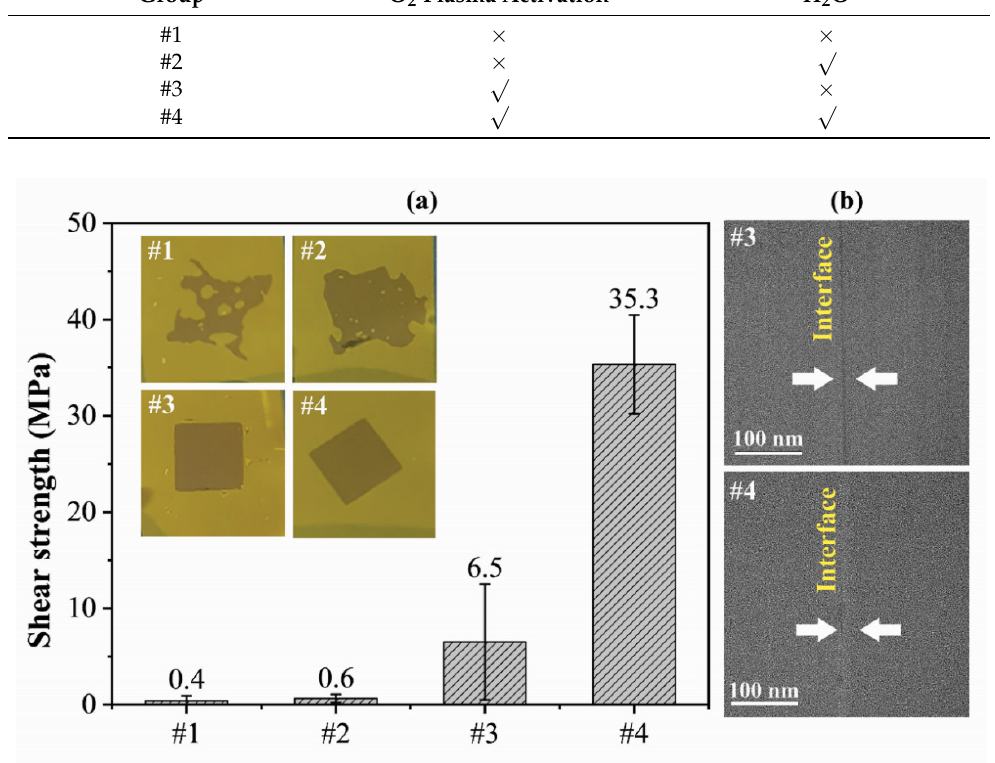
Figure 4. ( a ) The shear strength of specimens obtained in the comparative tests of Table 1; the inset images show the specimens after bonding under different conditions; ( b ) interface characterization of sample #3 and #4.